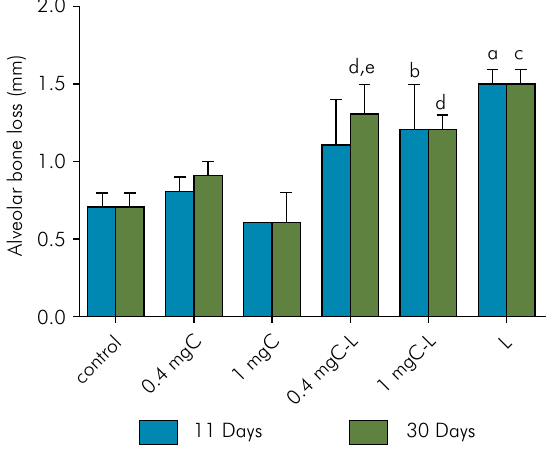
Figure 2. Mean alveolar bone loss of study groups.